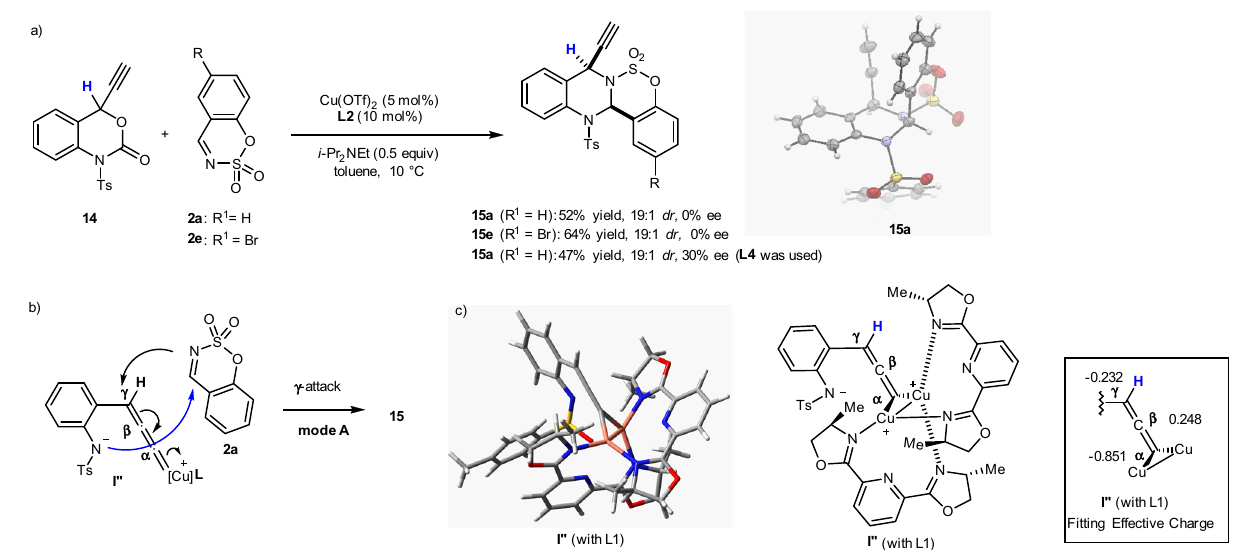
Fig. 9 Cu-catalyzed decarboxylative annulation of non-substituted 4-ethynyl benzoxazinanone 14. a Cu-catalyzed reaction of 14 with 2a , e . b The reaction mechanism involves mode A , not mode B , due to the favourable conformation of I ′′′ . c Optimized geometry of I ′′ ) (with L1 ) and calculated atomic